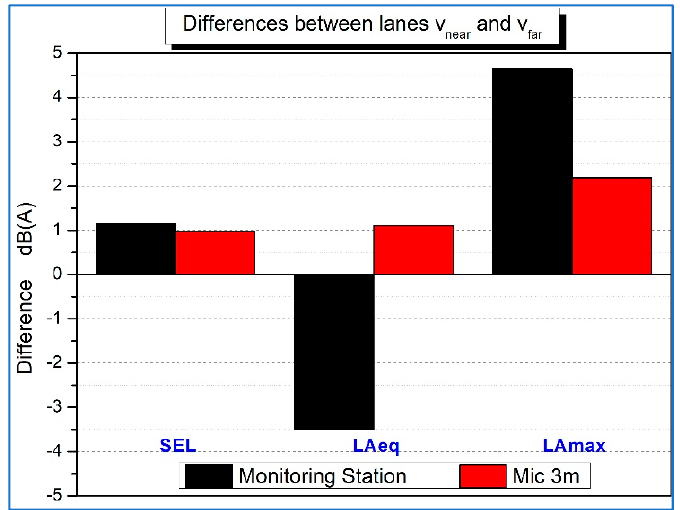
Figure 5. Difference between near and far lanes results with different parameters in T1 .